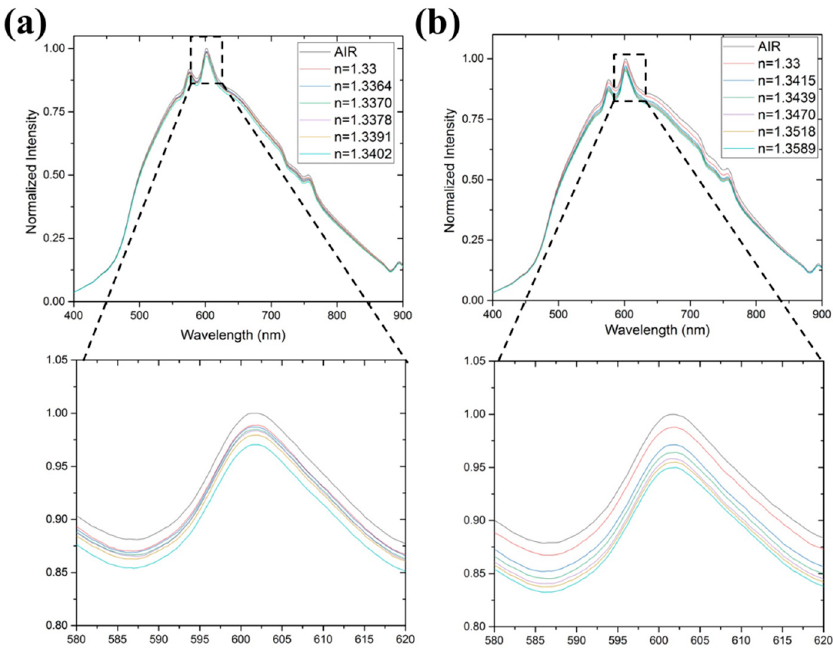
Figure 4. The normalized spectra of ( a ) methanol and ( b ) ethanol solutions with different refractive indices.